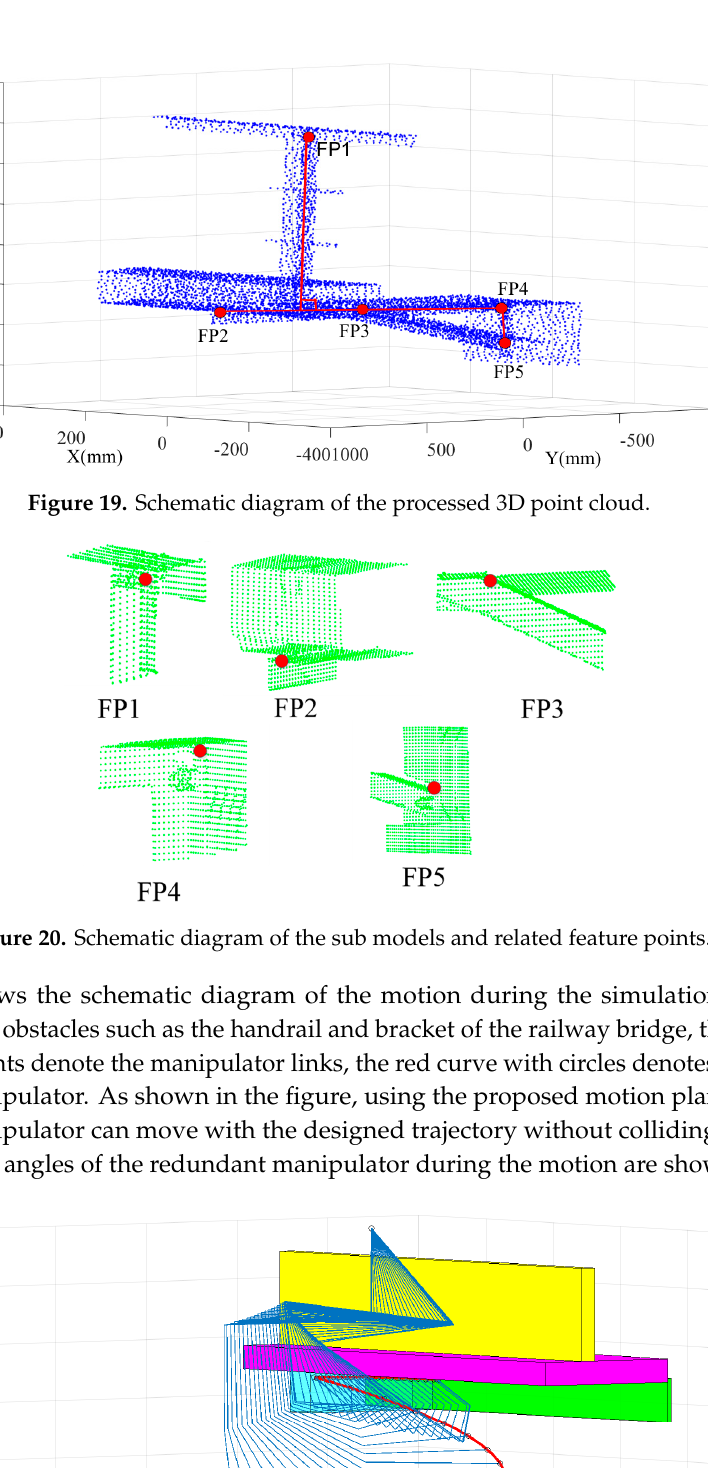
Figure 22. The joint angles of the redundant manipulator. The movement must be checked by the simulation system before the robot starts to work. If some part of the manipulator is too close to an obstacle in the simulation, the operator will adjust the position the base of the manipulator by the climbing mechanism. We must ensure safety before any